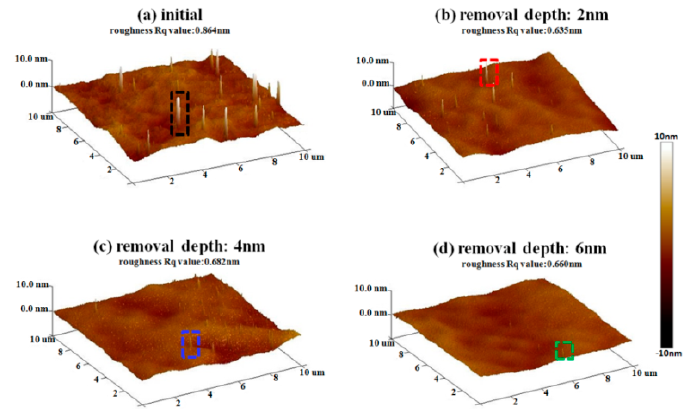
Figure 6. Bulges morphology evolution of sample #1 in EJP preprocessing.